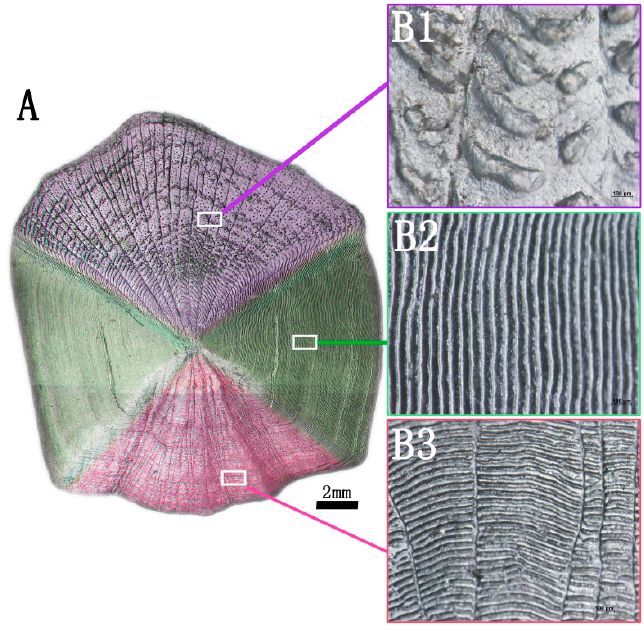
Figure 2. Surface image of grass carp scale ( A ), posterior field of fish scale ( B1 ), lateral field of fish scale ( B2 ), anterior field of fish scale ( B3 ).